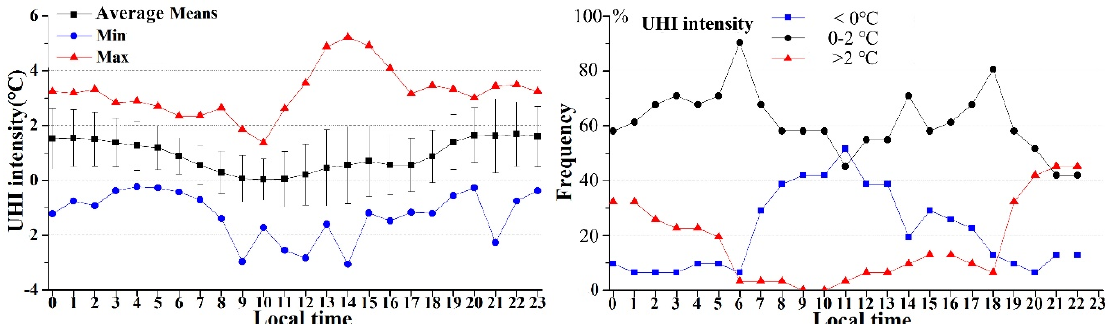
Figure 5. The average means hourly variations of UHI intensity and the hourly frequency distribution of different UHI intensity for the period of August 1–31 in Changchun city.